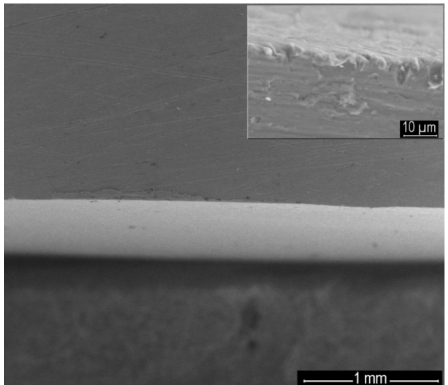
Figure 7. SEM image of the vertical section of the covered steel electrode with 5-(4-carboxy-phenyl)- 10,15,20-tris (4-methyl-phenyl)-porphyrin/MnTa 2 O 6 (h).